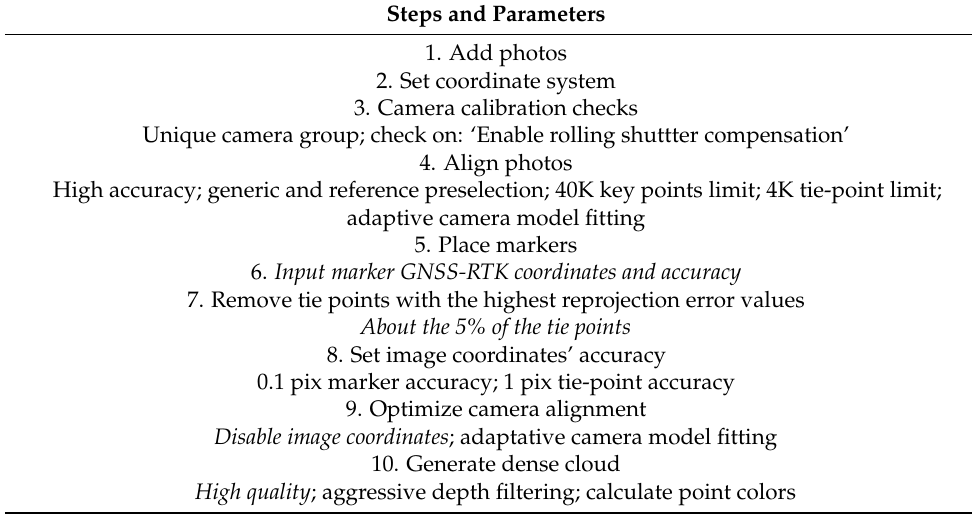
Table 2. Agisoft Metashape workflow and parameters based on Agisoft tutorials [39]. Parameters modified or not present in the Agisoft tutorial are shown in italics.